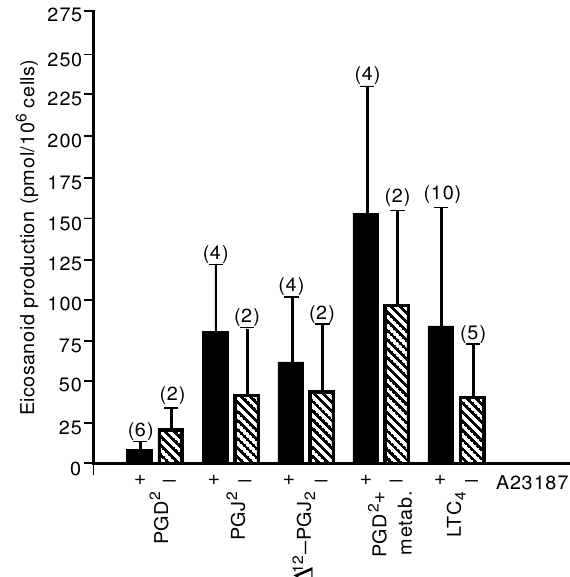
FIG. 2. Endogenous production of PGD 2 , PGJ 2 , D 12 -PGJ 2 and of total of these prostaglandins (PGD 2 + metab.) and of LTC 4 . BMMC were suspended in PBS with (+) or without (–) calcium ionophore A23187 (0.2 m M) for 30min at 37°C. Results are given as mean ± SD or range of two to 10 independent experiments (number in